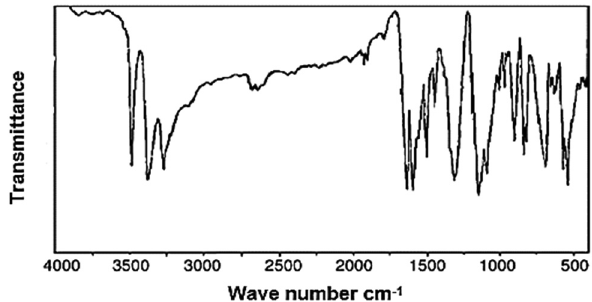
Figure 3: IR spectrum of the sulfanilamide in the range of 4,000 – 400 cm − 1